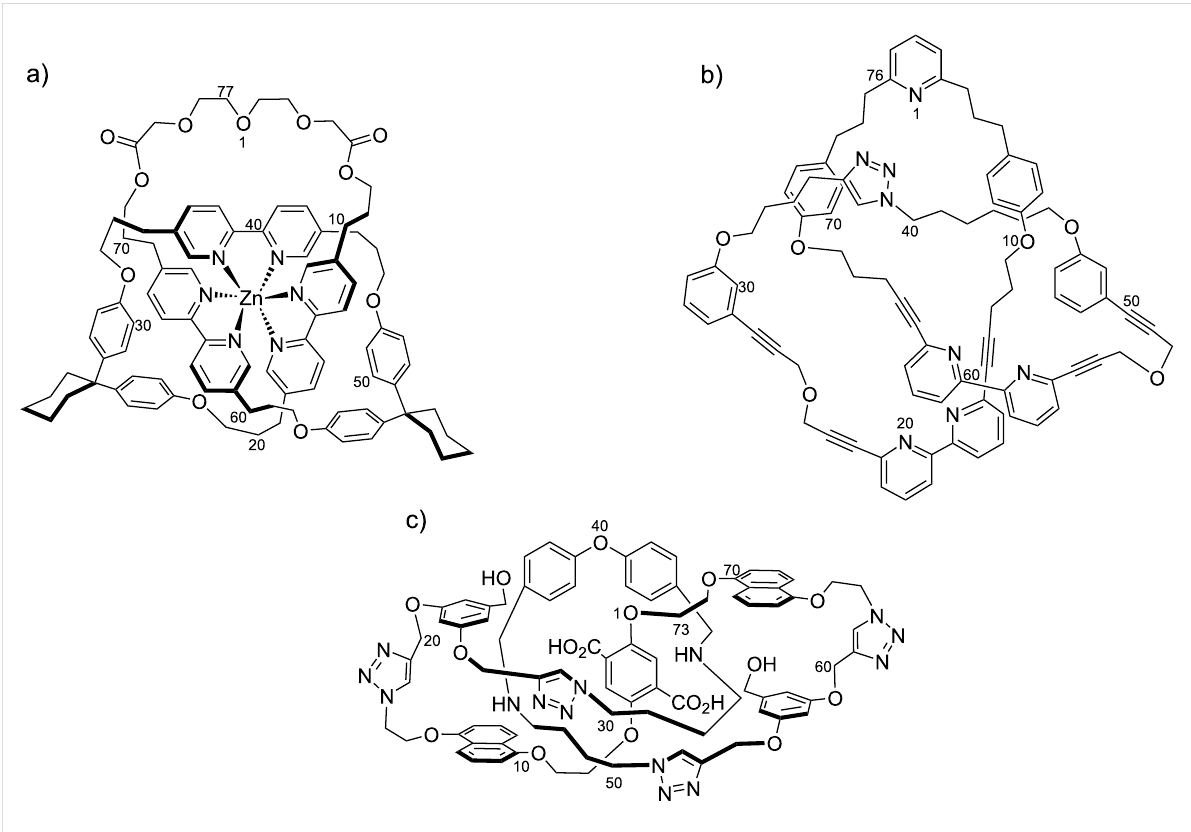
Figure 2: (a) Hunter’s 77 backbone-atom trefoil knot–metal complex [9]. (b) The world’s smallest knot: Leigh’s 76 backbone-atom trefoil [10]. (c) Target 73 backbone-atom trefoil knot of this work using host 1 and guest 2 .